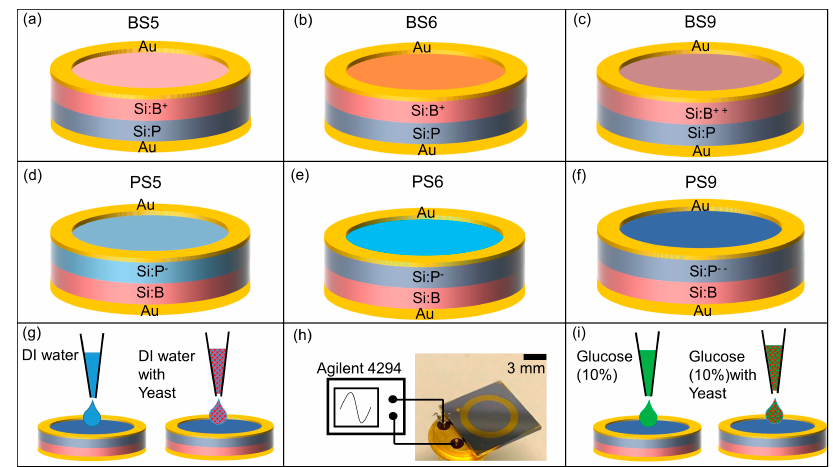
Figure 1. Schematic sketch of the p-n junction-based Si biochip with a ring top electrode with ( a – c ) boron ions (B + ) implanted into Si:P or with ( d – f ) phosphorous (P-) ions implanted into Si:B. BS6 ( b ) and PS6 ( e ) are annealed in nitrogen for 2 h. BS9 ( c ) and PS9 ( f ) are highly doped biochips. Top and bottom electrodes have been wire bonded to the pins of a TO-5 package ( h ) and connected to an Agilent 4294 A impedance analyzer. DI water ( g ) and S. cerevisiae suspension or 10% glucose as medium with S. cerevisiae ( i ) are added in to the top ring electrode for impedance spectroscopy.